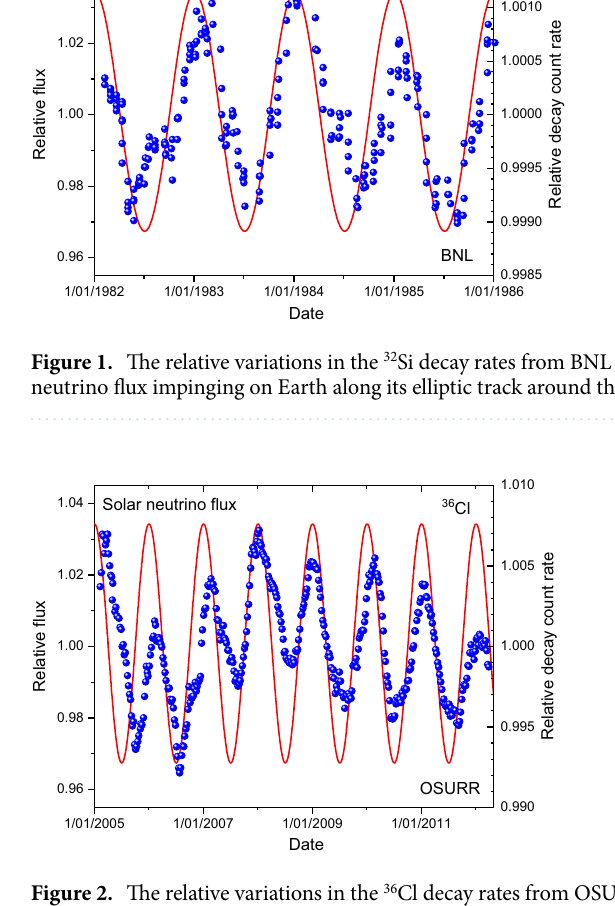
Figure 2. The relative variations in the 36 Cl decay rates from OSURR (dots) relative to the variations of the solar neutrino flux impinging on Earth along its elliptic track around the Sun